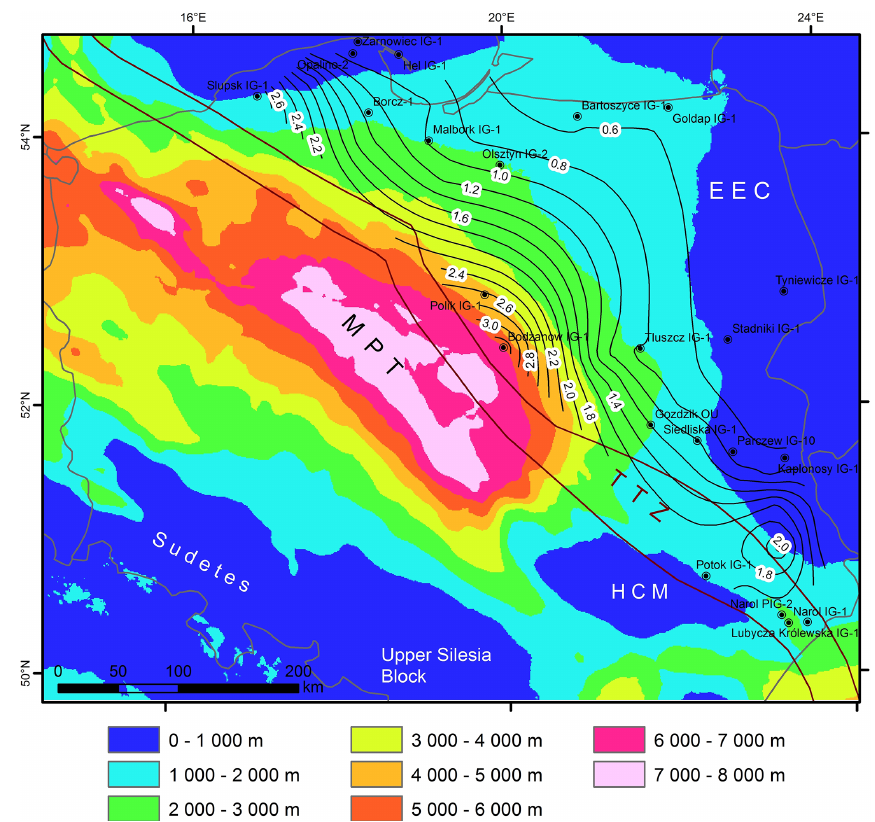
Figure 4. Permian–Cenozoic sediments isopach map for Poland adapted from Lamarche and Scheck-Wenderoth (2005), Maystrenko and Scheck-Wenderoth (2013), and Mazur et al. (2021). Isolines show mean vitrinite-equivalent reflectance model for the base of Silurian in NE Poland modified from Papiernik et al. (2019). EEC – East European Craton; HCM – Holy Cross Mountains; MPT – Mid-Polish Trough; TTZ – Teisseyre–Tornquist